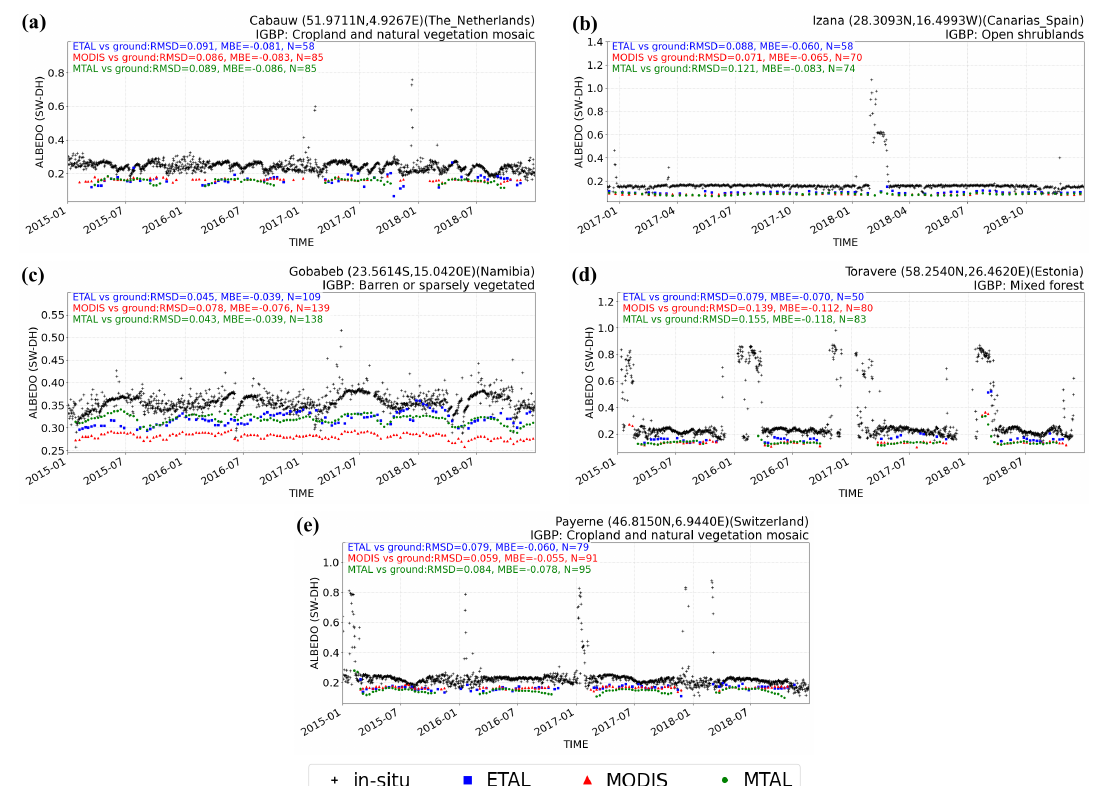
Figure A3. Time series of ETAL (ten-day period) against ground measurements (daily) for a set of ground stations: ( a ) Cabauw; ( b ) Izana; ( c ) Gobabeb; ( d ) Toravere; and ( e ) Payerne. All data are included. Equivalent MODIS- and MTAL-R/NRT-derived albedo measurements are also presented. Difference statistics (root-mean-square deviation (RMSD) and mean bias error (MBE)) between satellite estimates and ground measurements are included. N is the number of satellite albedo estimates for which a ground measurement is available (thus, the number of estimates used to calculate the statistics).